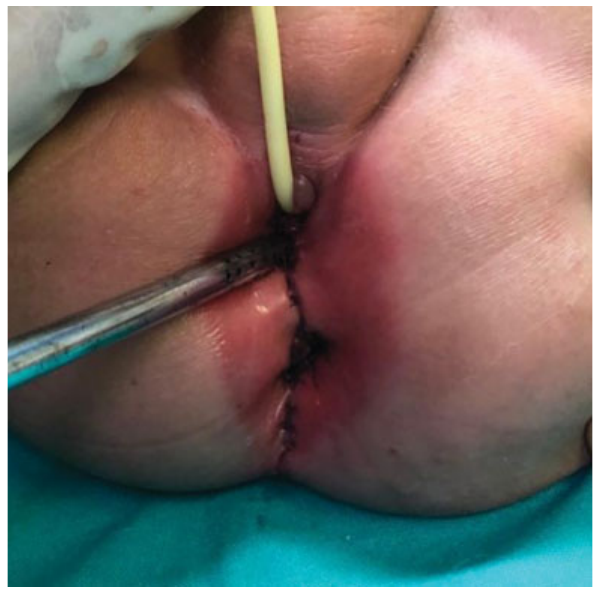
Fig. 4 Postoperative image: urinary catheter in urethra, suction catheter in vagina, and neoanus at inferior